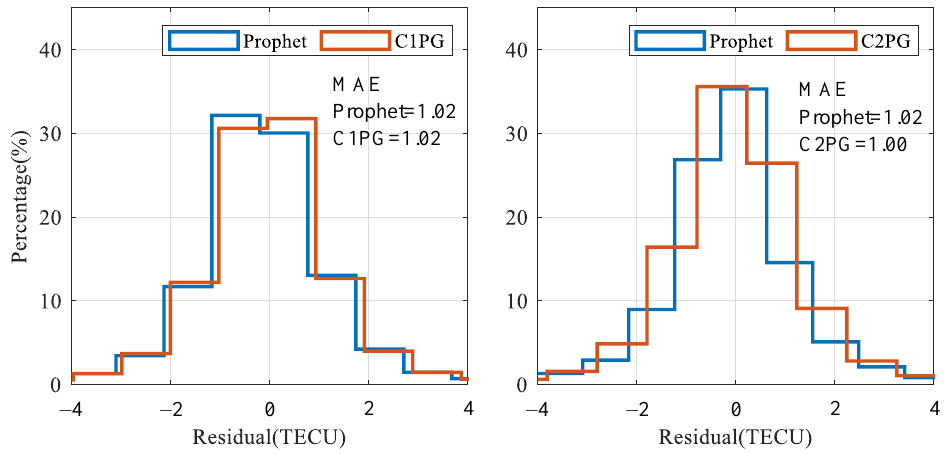
Figure 5. Forecasted residual distributions in a low-solar-activity year. Blue represents the Prophet model, and orange represents the COPG value.